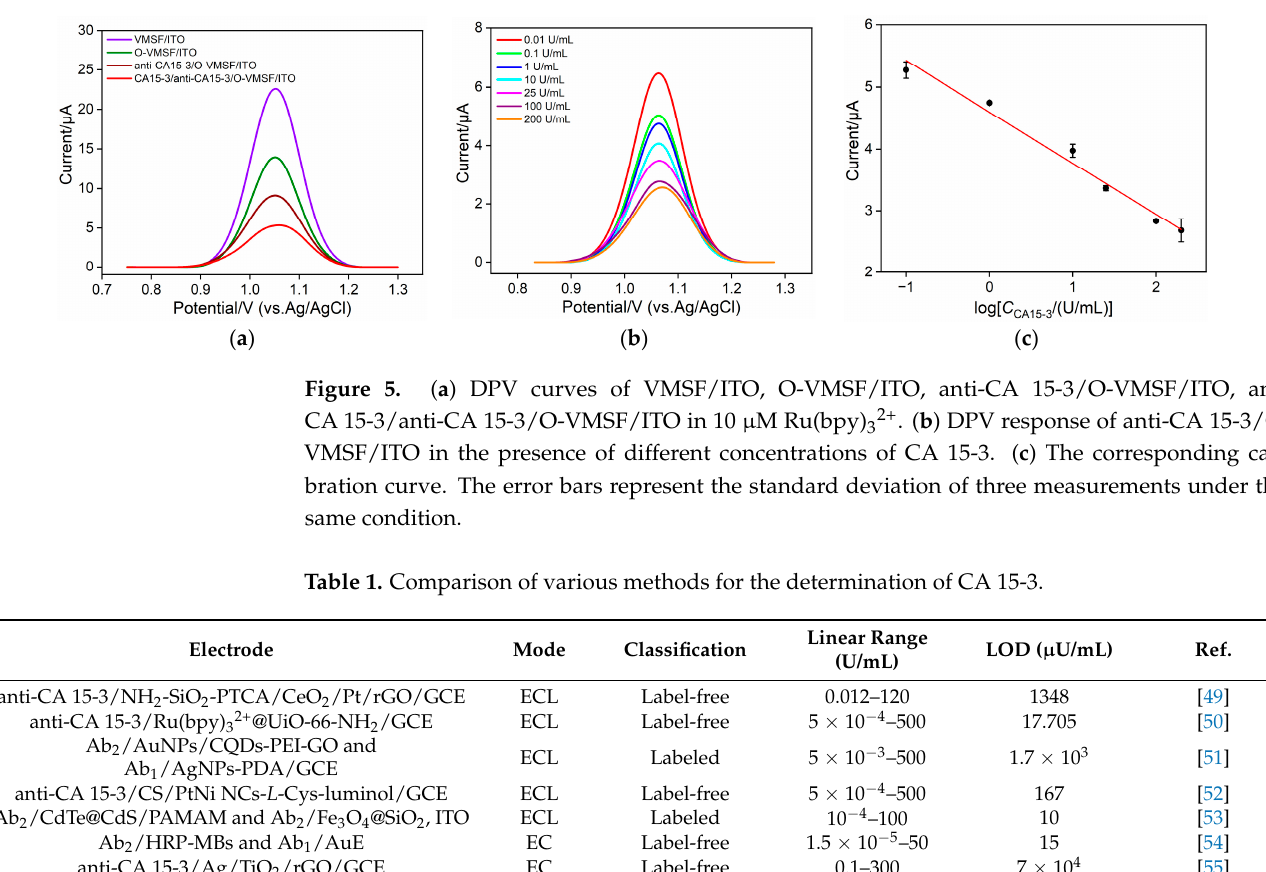
Ab 2 /CdTe@CdS/PAMAM and Ab 2 /Fe 3 O 4 @SiO 2 , ITO